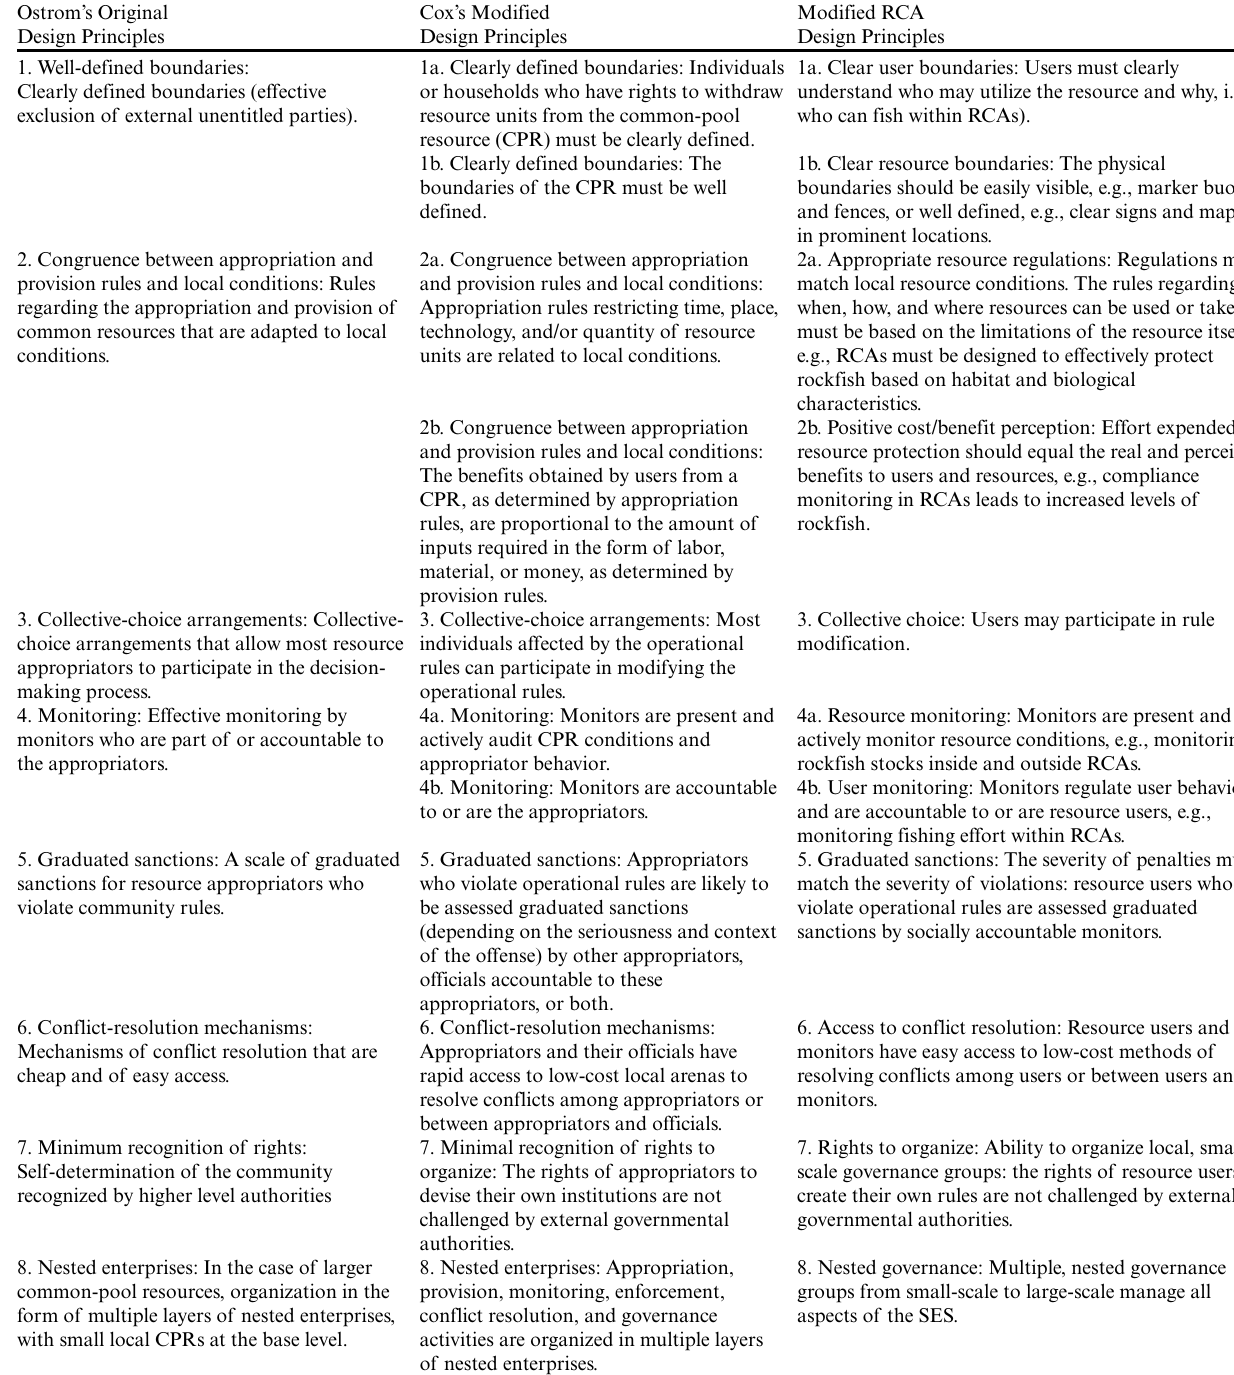
Table 3 . Design principles as originally created by Ostrom (1990), then modified by Cox et al. (2010) and further reworded for a Rockfish Conservation Area (RCA)